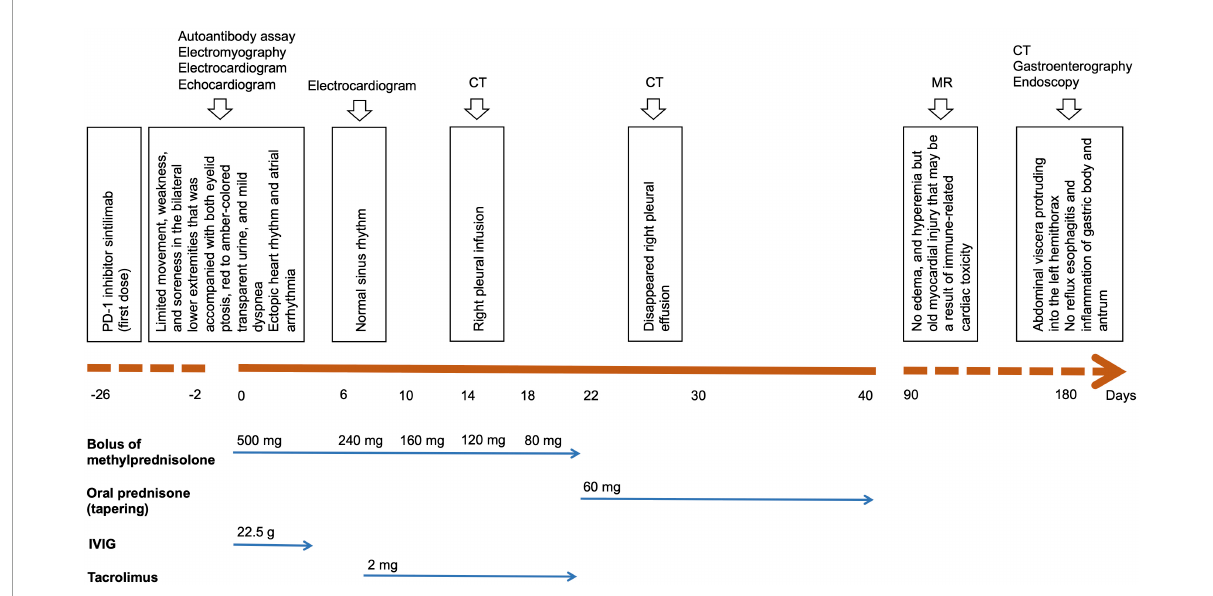
FIGURE3 Patient timeline chart along with key dates or durations for clinical manifestations, investigations, and treatments with steroids and immunosuppressive agents.